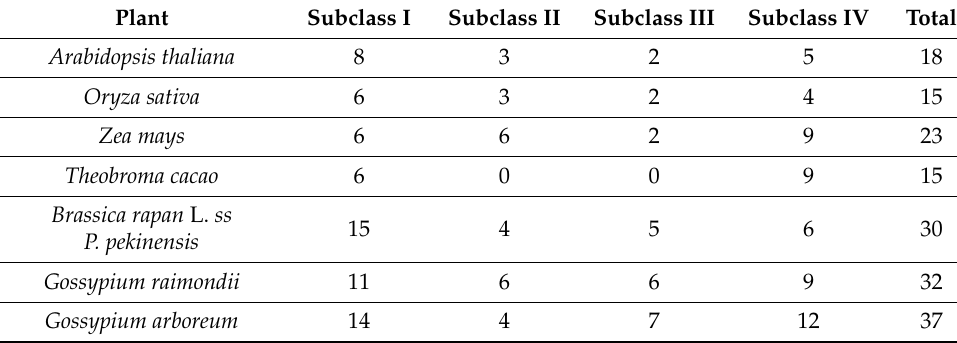
Table 1. Number of predicted genes for each GR-RBP subclass in various plants.